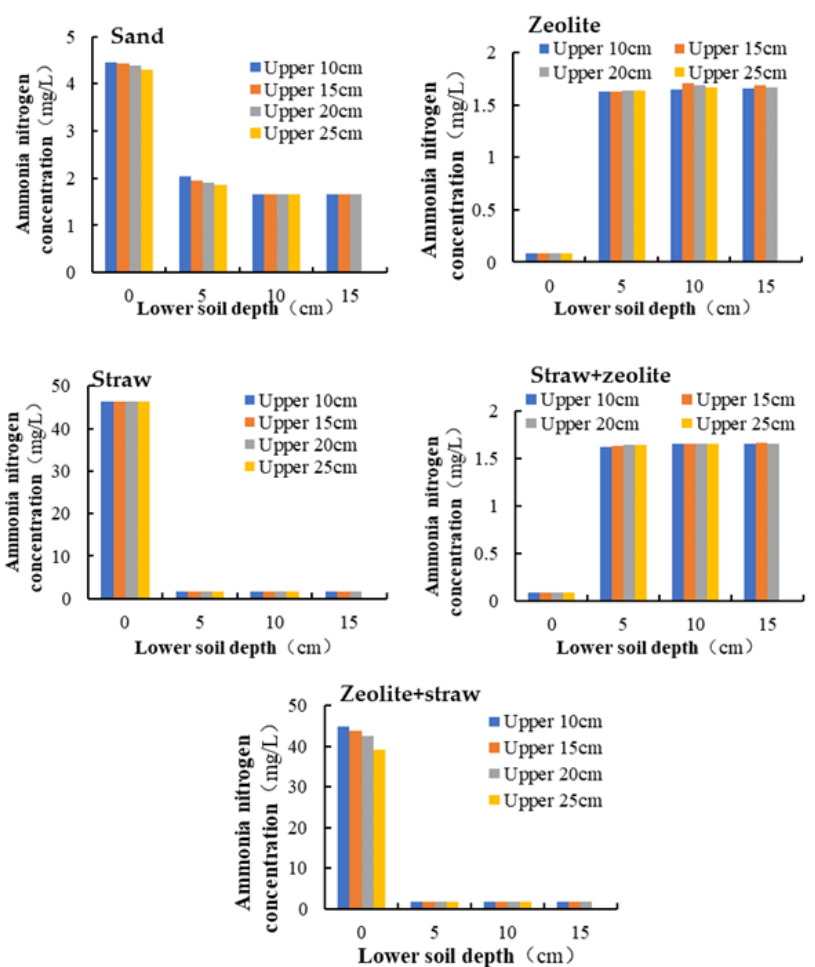
Figure 8. NH 4+ -N concentrations with different depth of upper and lower soil. Figure 8. NH 4 + -N concentrations with different depth of upper and lower